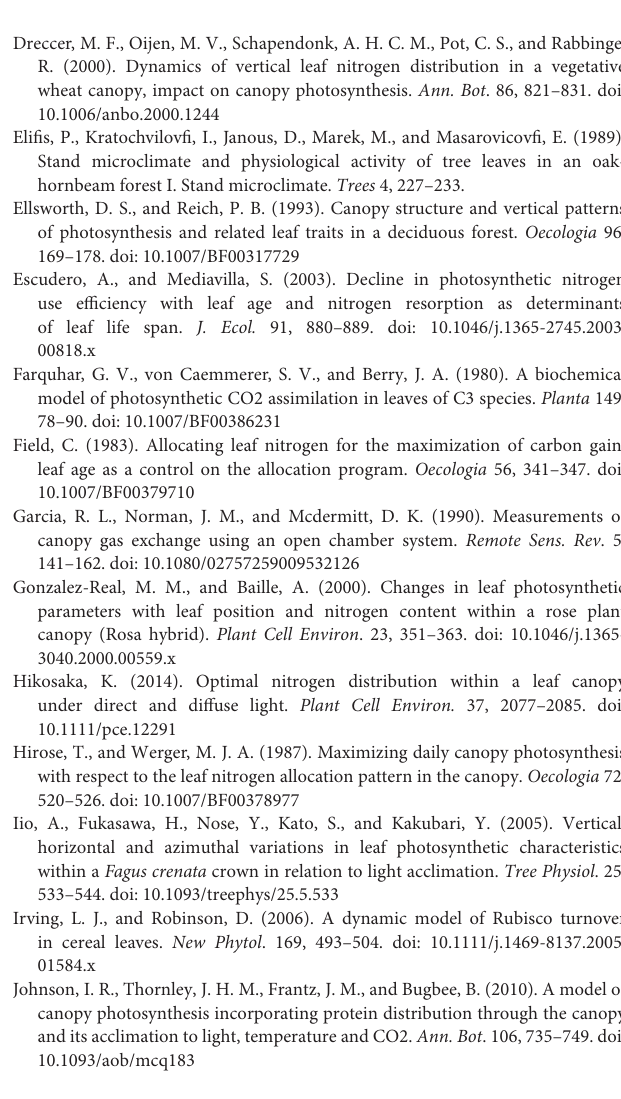
Figure S1 | Change in CO 2 concentration in the closed chamber without plant for